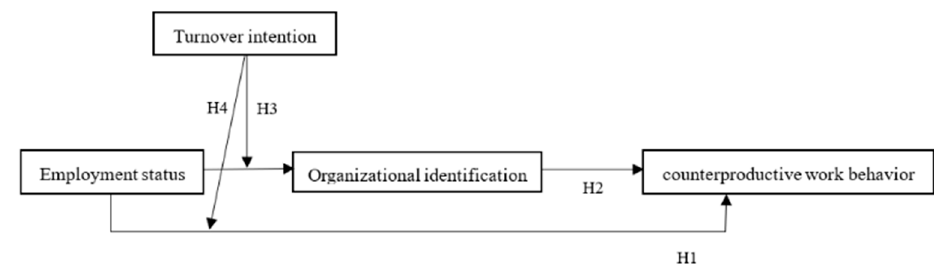
Figure 1. The hypothesized mediation and moderation model.